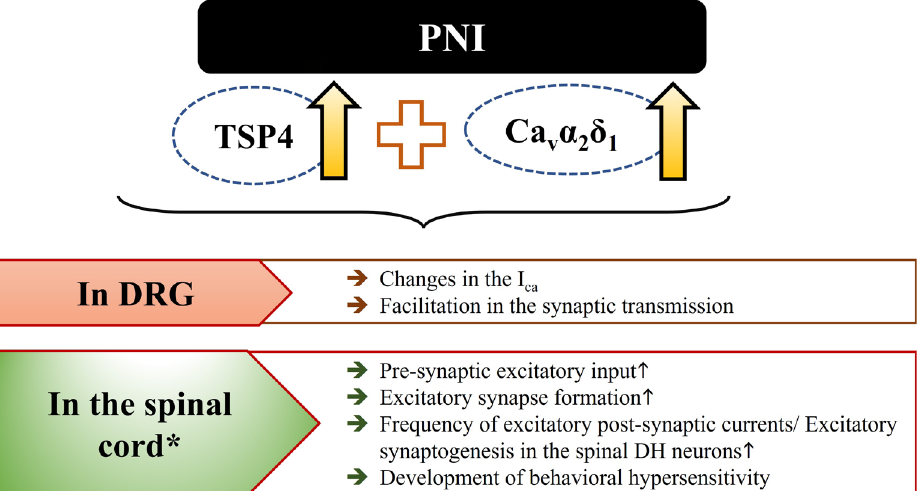
α δ in DRG and DSC following PNI. It has been inspired v 2 1